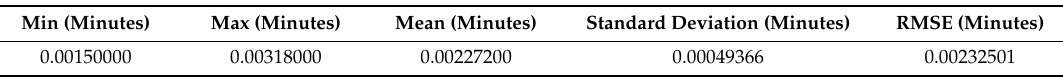
Table 16. Statistical values of the residuals for the latitude coordinates resulting from datum Table 15. Statistical values of the residuals for the longitude coordinates that result from datum transformation OSPM / ED50 to OSPM / WGS84 based on automatic QGIS transformation OSPM/ED50 to OSPM/WGS84 based on an automatic QGIS application.